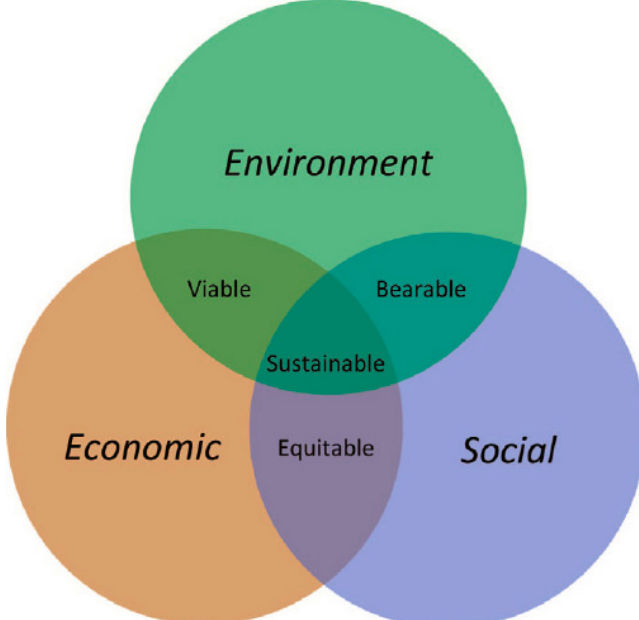
Figure 2. The pillars of sustainability [88].